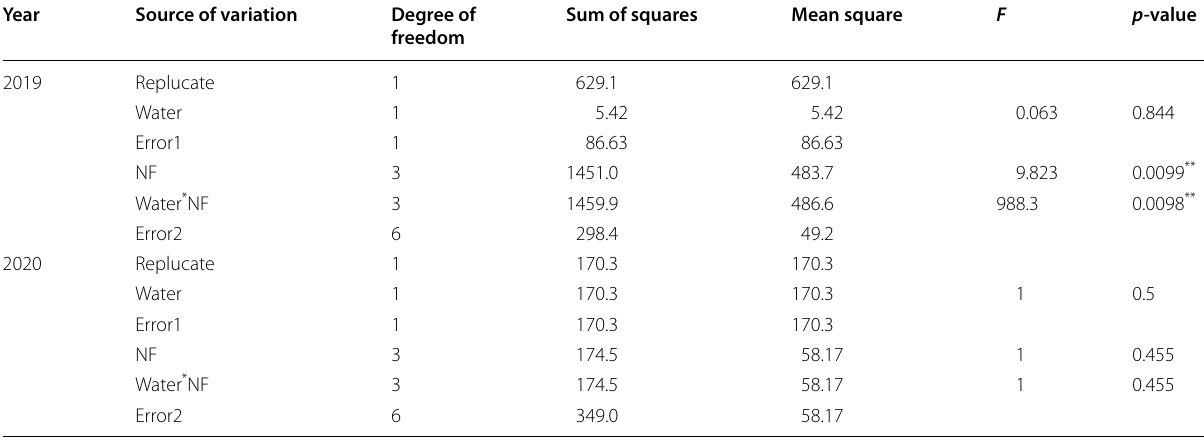
** values are significant at p <